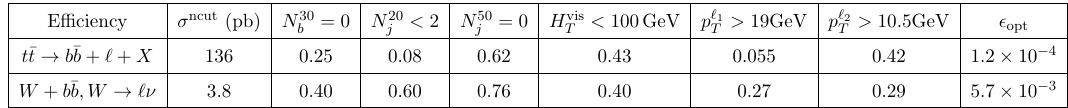
(cid:0) (cid:1) d ‘ > d 0 . The two dashed gray lines with 0